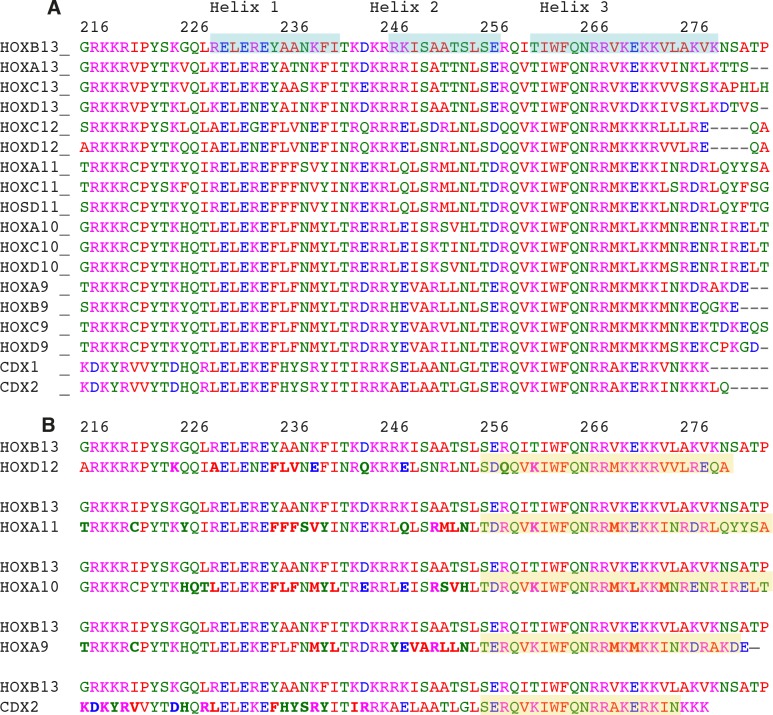
HOXB13 - HOXes/CDX mutations.(A) Sequence alignment of HOXB13 with other HOXes. Secondary structure (alpha-helixes) of HOXB13 is highlighed in cyan. (B) The pairwise alignment; note that in addition to single mutations there are combined mutations and replacement of Helix 3 (DNA-binding helix) to corresponding helix of other HOXes (highlighted in yellow). The numbering on the top of the sequences is HOXB13 numbering.